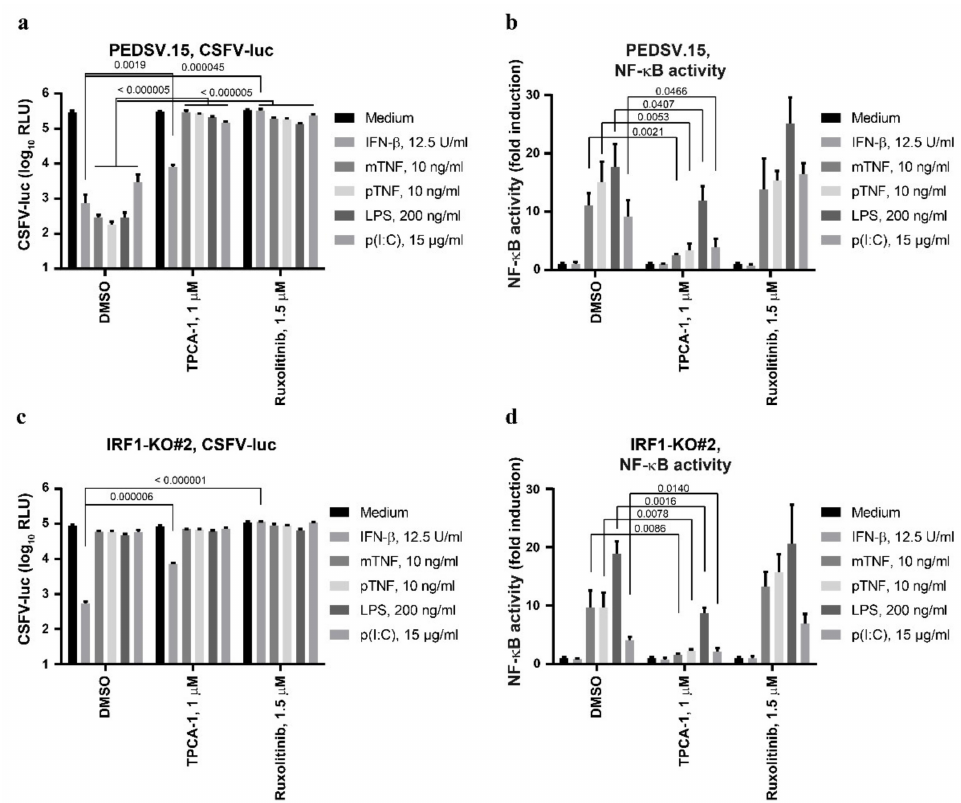
Figure 5. The anti-CSFV activity of TNF depends on NF- κ B, but NF- κ B can function independently of IRF1. The PEDSV.15 ( a , b ) or PEDSV.15-derived IRF1-KO cells (IRF1-KO#2) ( c , d ) were transfected with the NF- κ B reporter plasmid 18 h prior to stimulation ( b , d ) or left untransfected ( a , c ) and stimulated with IFN- β , mTNF, pTNF, LPS or p(I:C) in the absence (DMSO) or presence of TPCA-1 or ruxolitinib at the indicated concentrations. The untransfected cells ( a , c ) were infected with CSFV-luc seven hours after stimulation. Firefly luciferase ( a , c ) or firefly and Renilla dual-luciferase activities ( b , d ) were measured 24 h after infection or six hours after stimulation, respectively. The NF- κ B-dependent promoter activity is plotted as fold induction compared to the medium. The data represent the means and the standard deviations of at least three independent experimental replicas. Significant differences compared with the medium ( p < 0.05) were calculated with the unpaired, two-tailed Student’s t -test (the p -values are indicated; ns,